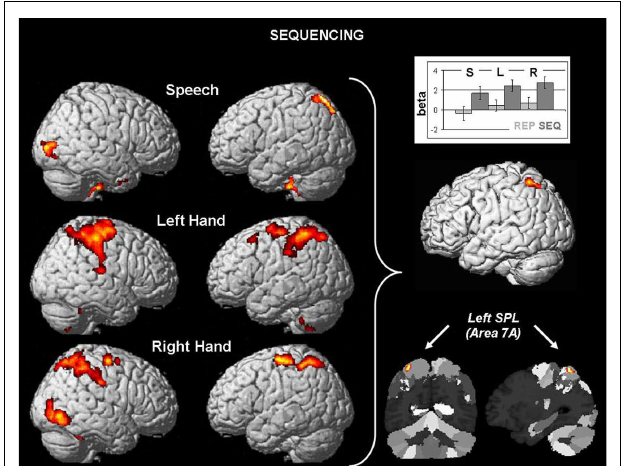
FIGURE 1 | Left: surface rendering of differential brain activation in the sequencing condition (A-B-A) as compared to repetition (A-A-A) as a function of effector (speech, left hand, right hand). All results are displayed at an FWE-corrected threshold of p < 0.05, effected as uncorrected maps at p < 0.001 with a cluster size of k ≥ 250 voxels. Right: Conjunction of the three sequencing effects yields one common region in the left superior parietal lobule in area 7A. Sections illustrate the position of the activation relative to the cytoarchitectonic maximum probability map (Scheperjans et al., 2008).The bar graphs shows the consistency of higher activation in the sequencing conditions (dark gray) as compared to repetition (light gray) in speech (S), left hand movements (L), and right hand movements (R).